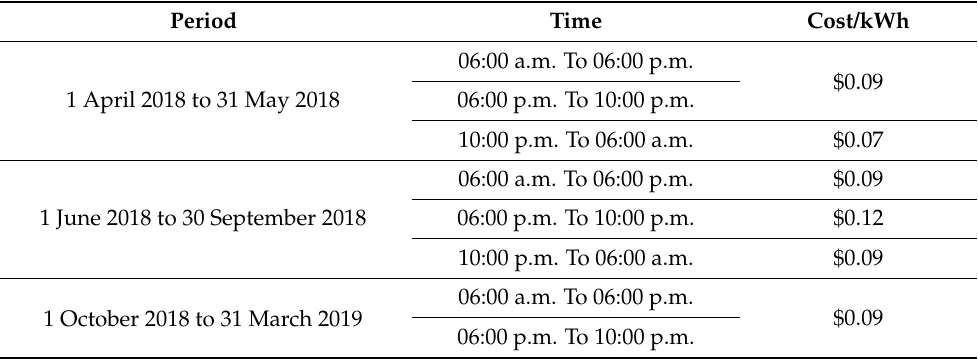
Table 2. PSPCL ToD